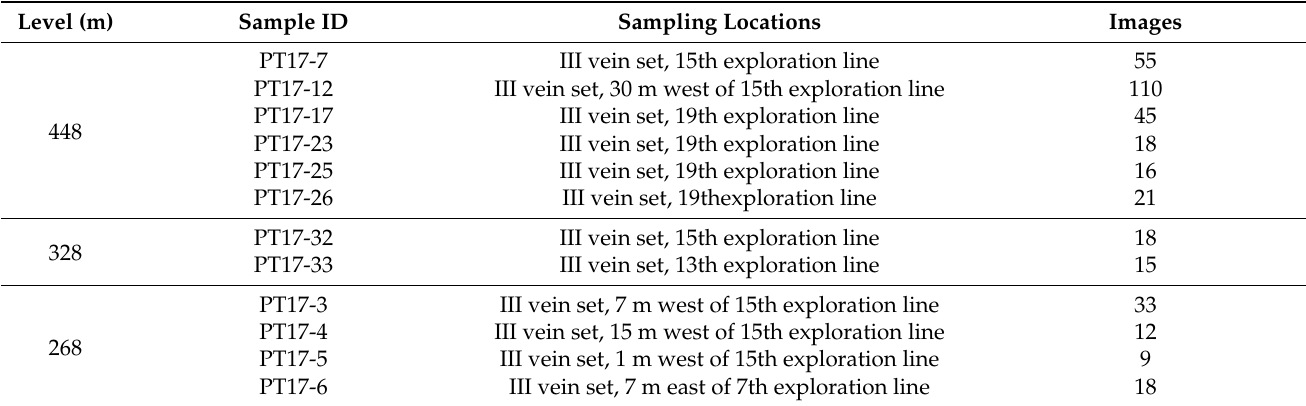
Table 2. The vein samples used for SEM–CL